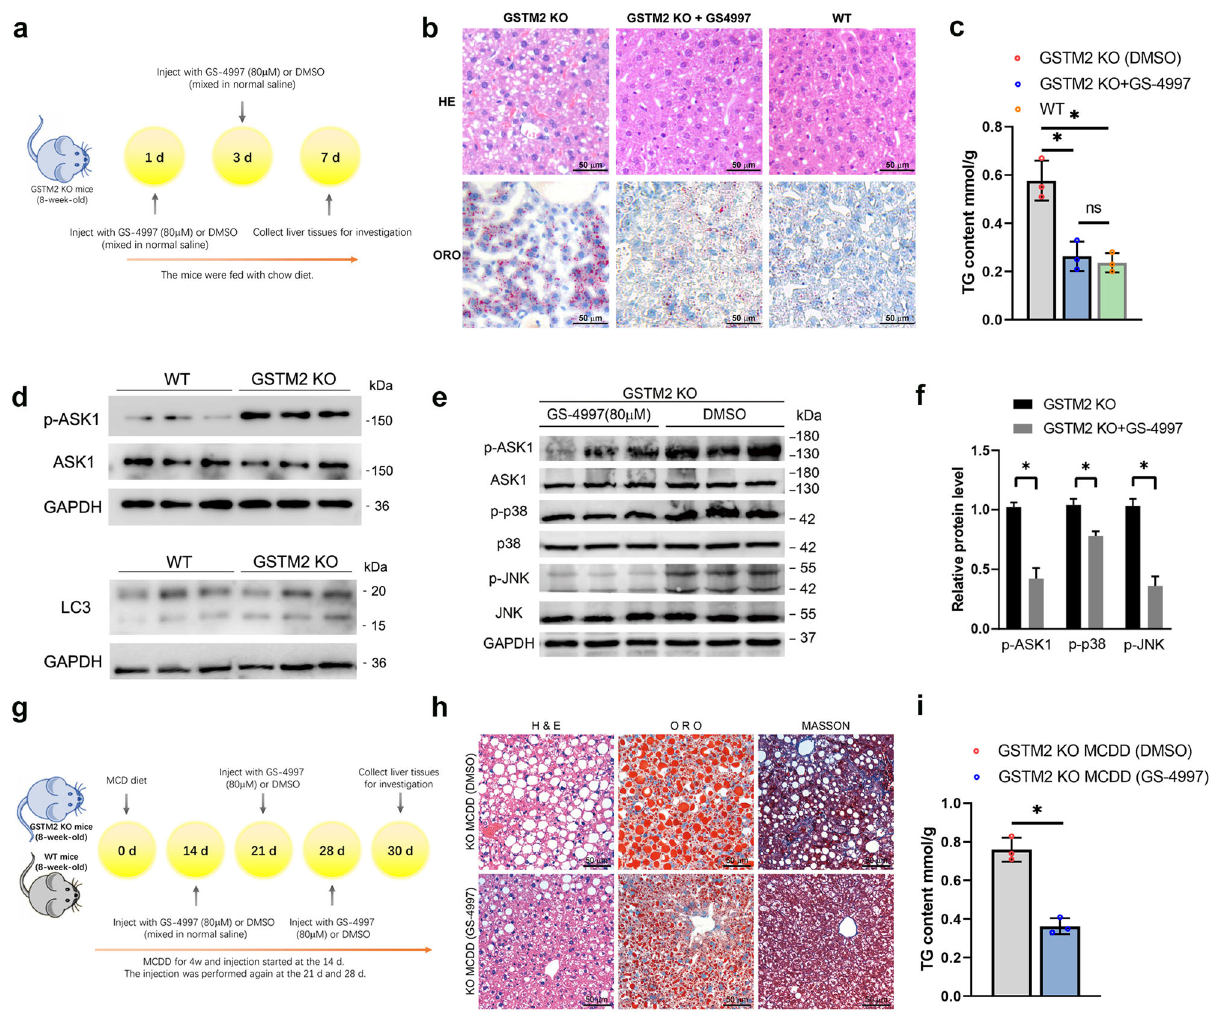
Fig. 6 GSTM2 KO induced hepatic fat accumulation was suppressed by GS-4997 in vivo. a The GSTM2 KO mice were fed with chow diet and treated with GS-4997 or DMSO at day 1 and 3, then the liver tissues were collected for further analysis. b GSTM2 KO mice were treated with GS-4997 (ASK-1 inhibitor) by intraperitoneal injection. Hepatic fat was detected by HE and ORO staining. c TG content examination of WT mice fed MCDD with GS-4997 or DMSO treatment. d WB detection of expression level of p-ASK1 and LC3 in GSTM2 KO mice liver. e Investigation of protein levels of ASK1 signalling pathway in GSTM2 KO mice with GS-4997 or control, DMSO treatment by Western blot. f Fray value analysis of ( e ) by ImageJ software. g The WT and GSTM2 KO mice were fed with MCD diet for one month. The mice were treated with GS-4997 or DMSO at day 14, 21 and 28, and then the liver tissues were collected for further Analysis. h GSTM2 KO mice were fed MCDD and treated with GS-4997 or DMSO by intraperitoneal injection. Then hepatic fat and fi brosis level were detected by HE, ORO and Masson staining. i TG content examination of GSTM2 KO mice fed MCDD with GS-4997 or DMSO treatment. bar, 50 μ